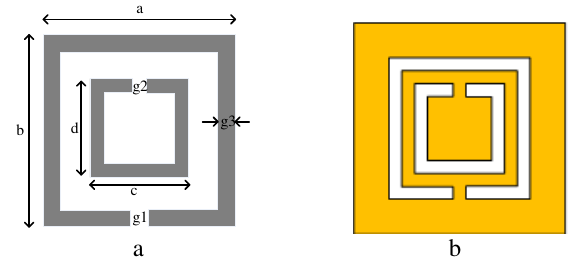
Figure 2: Topology of a SRR and b CSRR